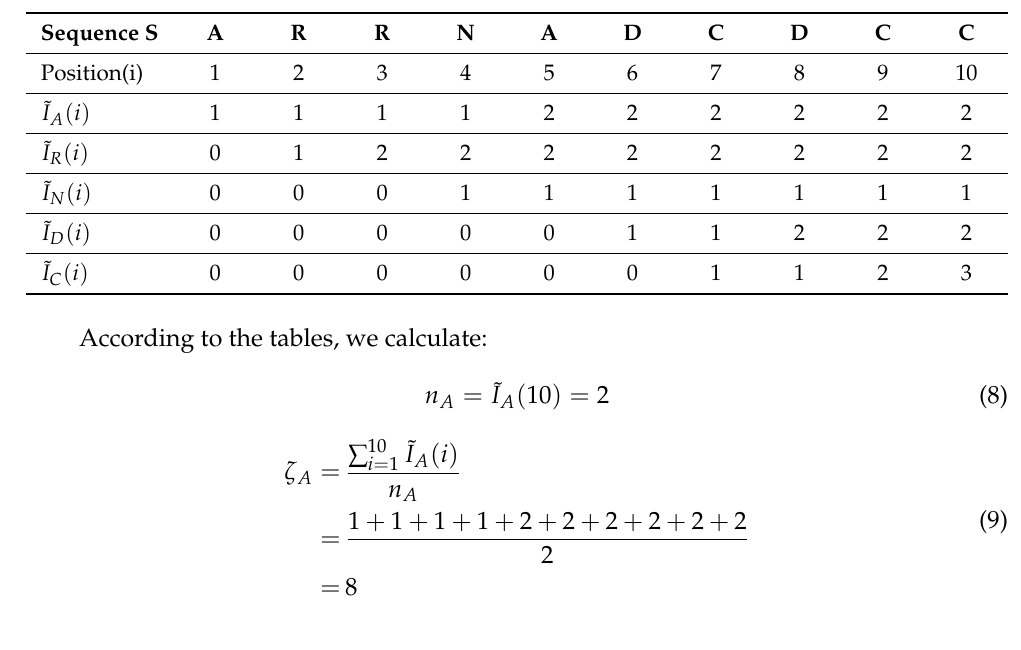
Table 2. The accumulated indicator functions of